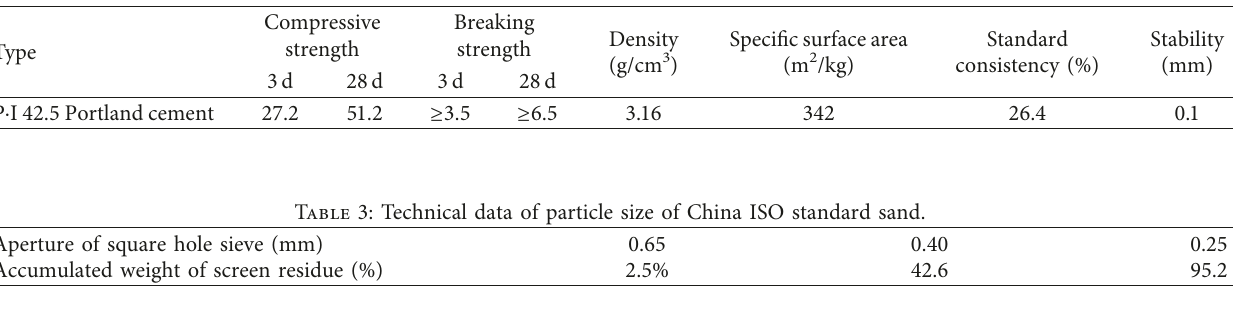
Table 2: Physical properties of the reference